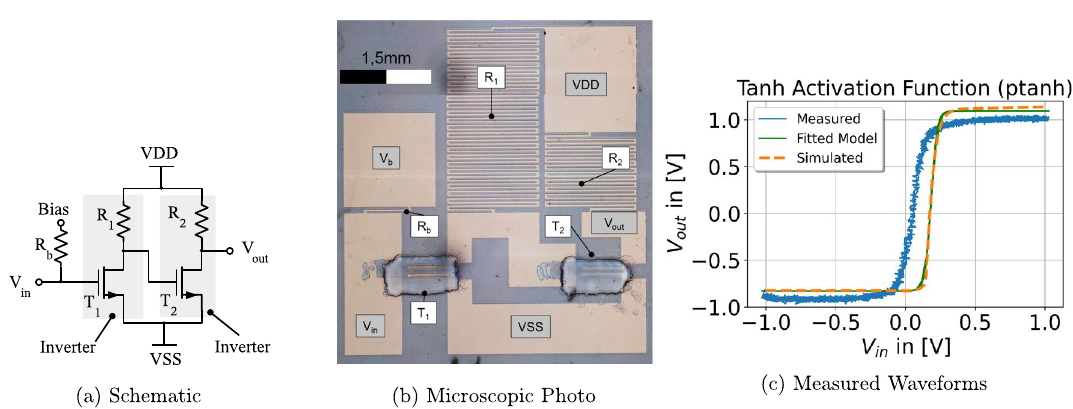
Figure 3. ( a ) The schematic of the proposed negative weight circuit. Two voltage dividers are deployed to shift the zero-crossing of the output voltage towards 0V . ( b ) Depicts the microscopic photo of the hardware prototype. ( c ) Contains the simulated and measured transfer function of the circuit.